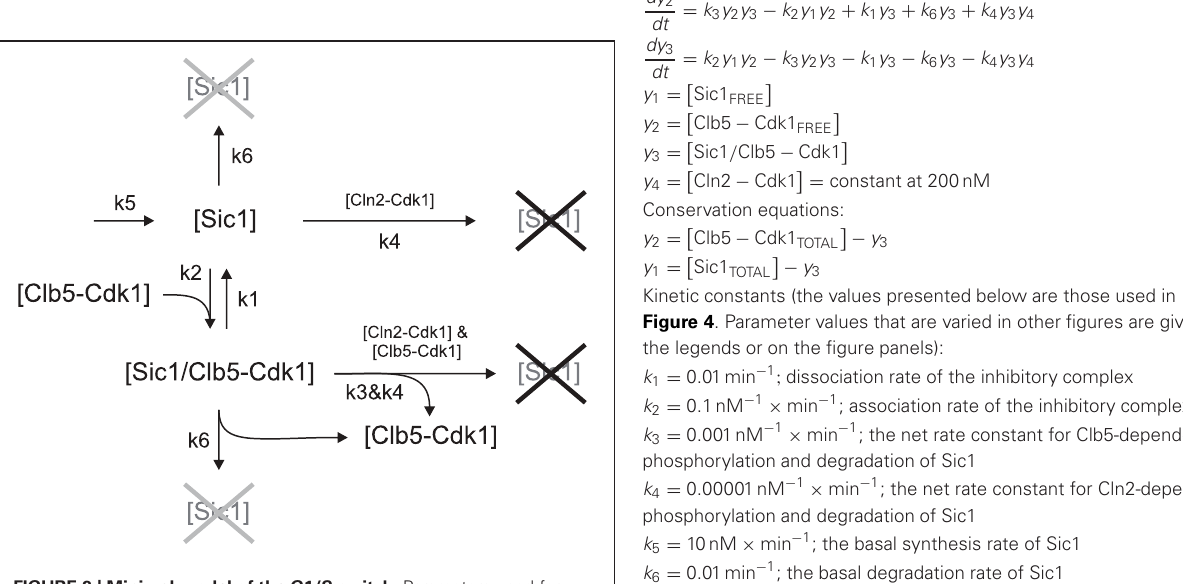
FIGURE 3 | Minimal model of the G1/S switch. Parameters used for diagrams and simulations presented in the figures below are listed in Tables 1 and 2 . Black crosses designate the phospho-dependent degradation of Sic1 via the SCF-proteasome pathway. Gray crosses designate basal degradation of